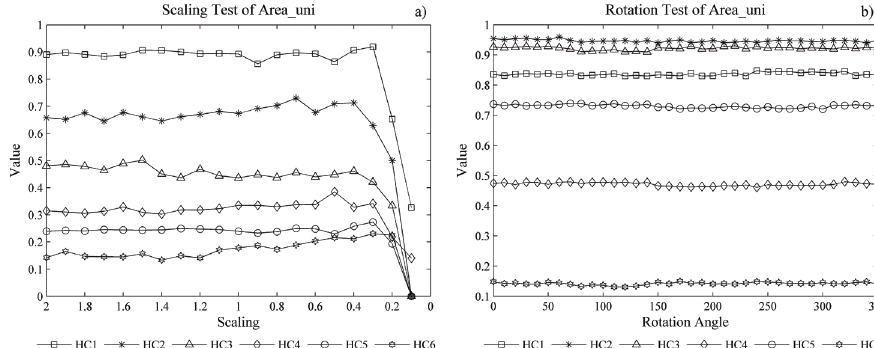
Figure 6. Tests of Area_uni with Various Hydrophobic Levels. a) Scale Transformation, b) Rotation Transformation.